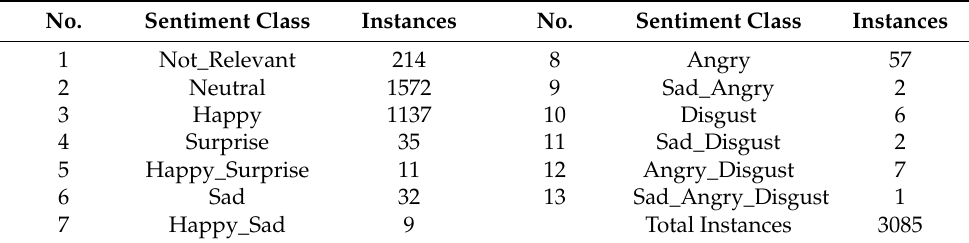
Table 1. Tweets distribution in sentimental